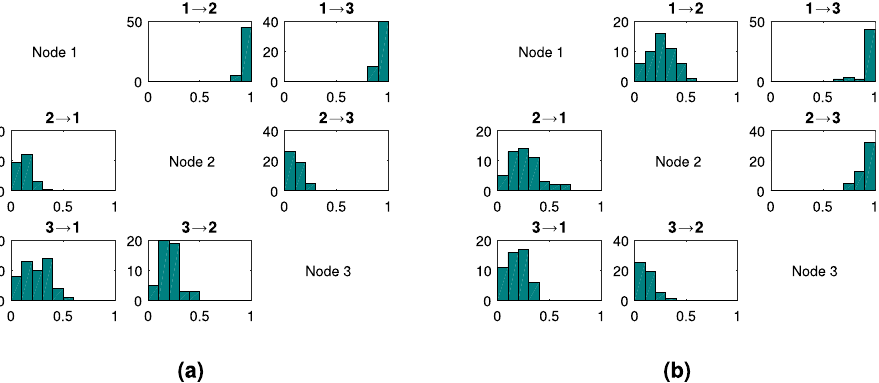
Figure 3. Histogram of lsNGC scores (normalized between 0 and 1) for the ( a ) 3-fan out, ( b ) 3-fan in networks over 50 different sets of the simulation. ( a ) The influence of x 1 on x 2 and x 3 is captured quite well across the 50 simulations. ( b ) The influence of x 1 and x 2 on x 3 is captured quite well across the 50 simulations. Generated with MATLAB R2016a 40